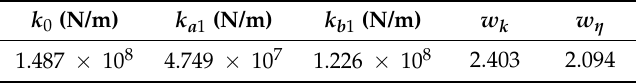
Table 3. The fitting parameters for the example gear